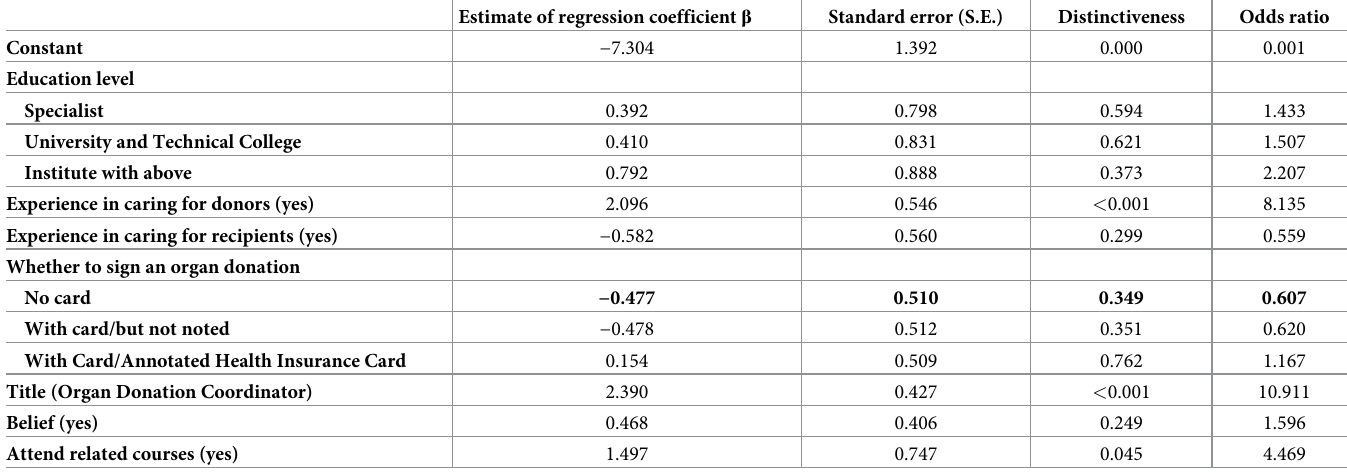
Table 4. Regression results for basic attributes with regard to soliciting organ donations.